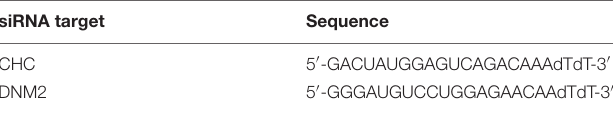
Frontiers in Cell and Developmental Biology |